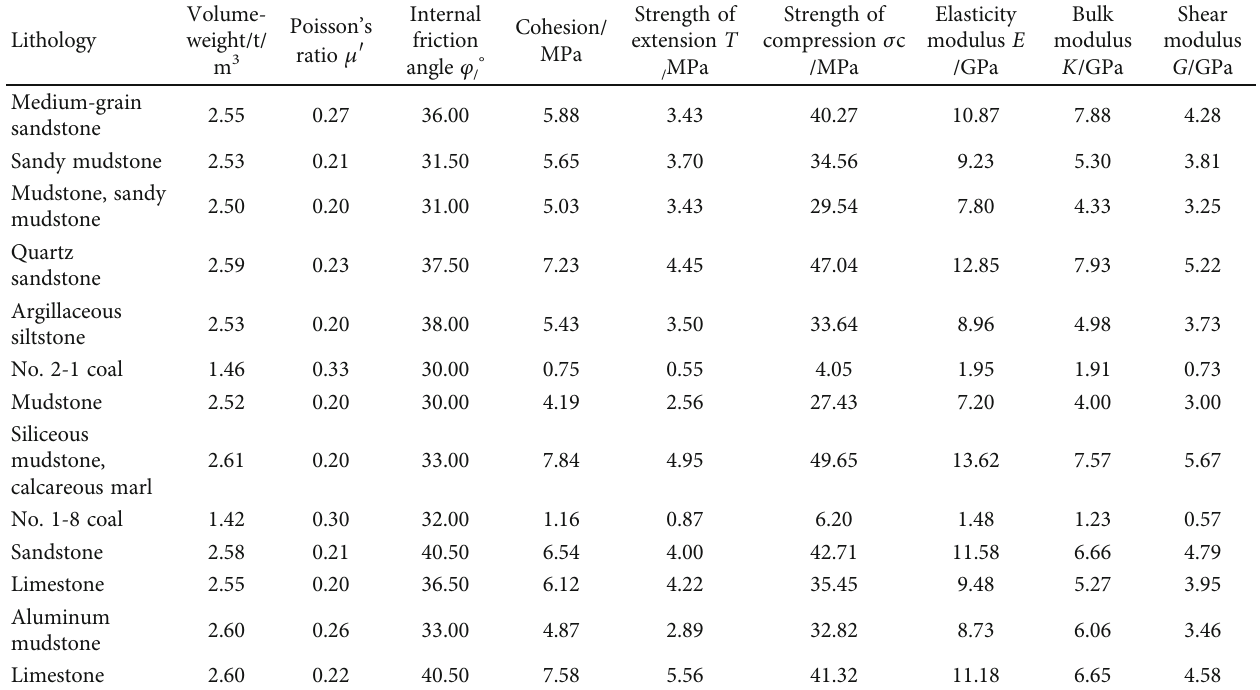
Table 1: The mechanical parameters coal and rock.